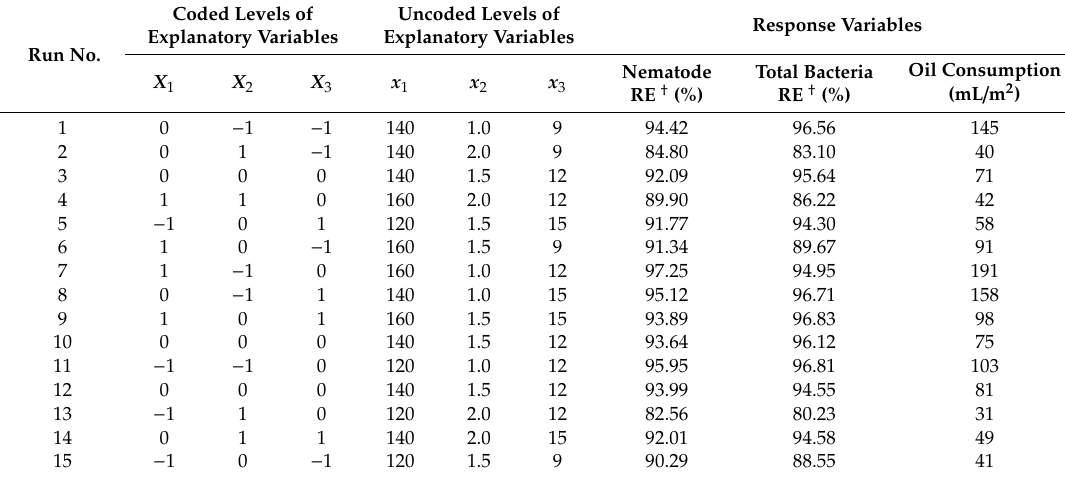
Table 2. Box–Behnken design with the experimental values and calculated results for the response variables in each experiment.